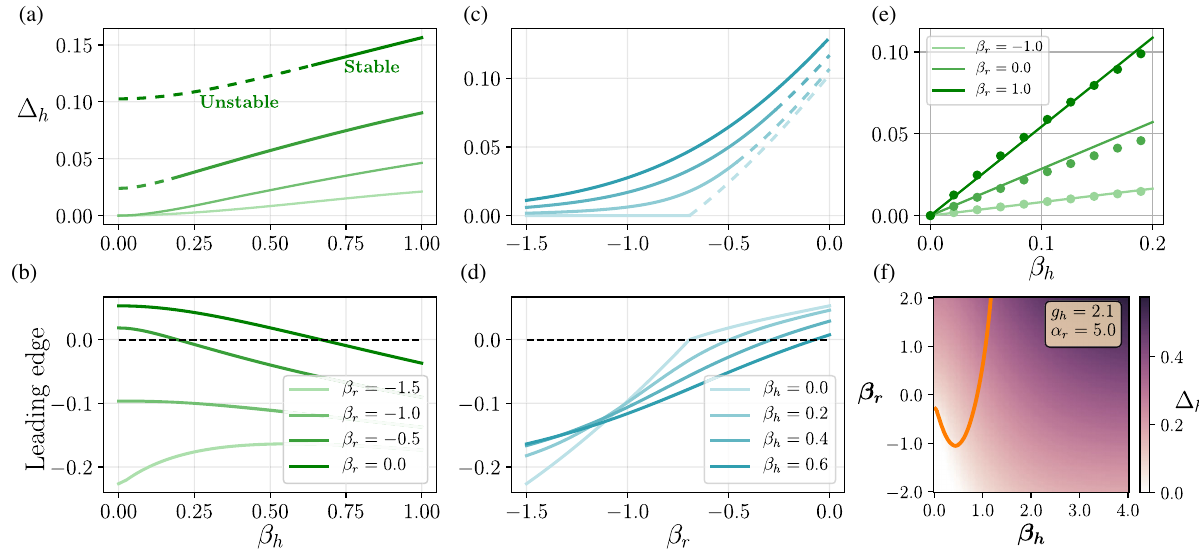
; different shades of green correspond to different values of h ; different r . (d) Similar to (b) but for β . (e) FP solutions near critical g where the zero FP h r c r